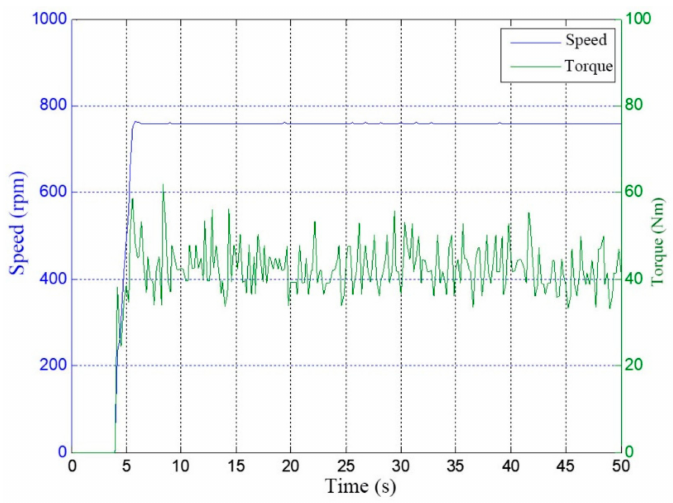
Figure 20. Heavy-load working